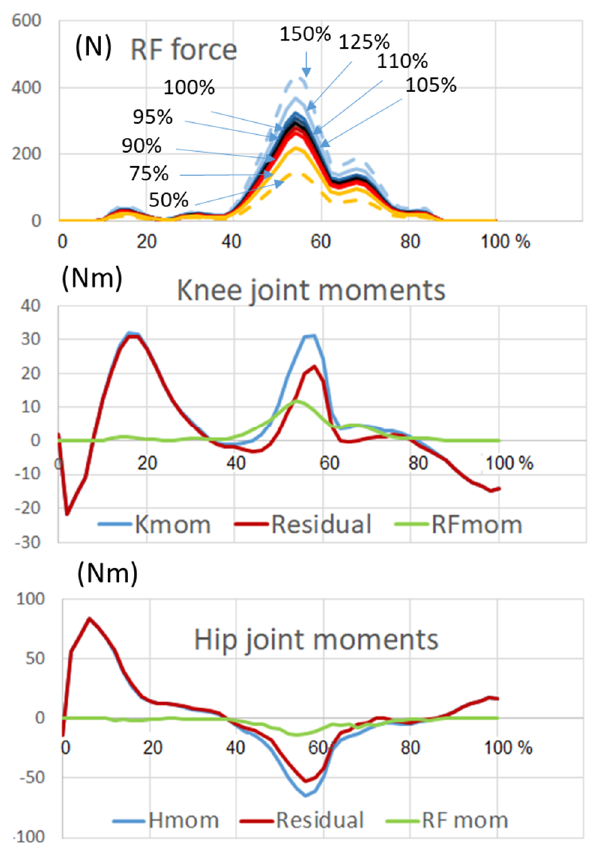
Figure 1. Above: different percentages of rectus femoris (RF) force input into the model (the force exerted in the unperturbed stride movement was 100%); middle and low: Knee and hip joint moments produced in unperturbed condition by all muscles (Kmom, Hmom, blue line), by the RF muscle (RFmom), and by other muscles than the RF (residual moments).